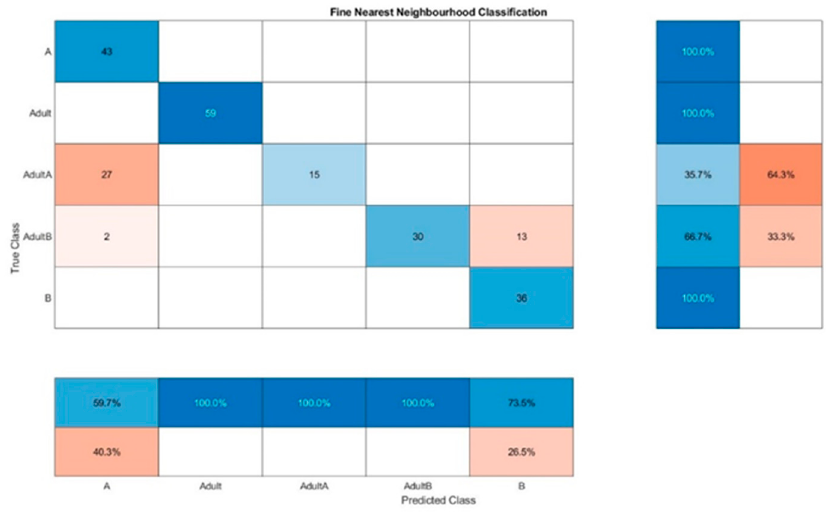
Figure 6. Confusion matrix for the oil classification by KNN out of the Raman spectra.